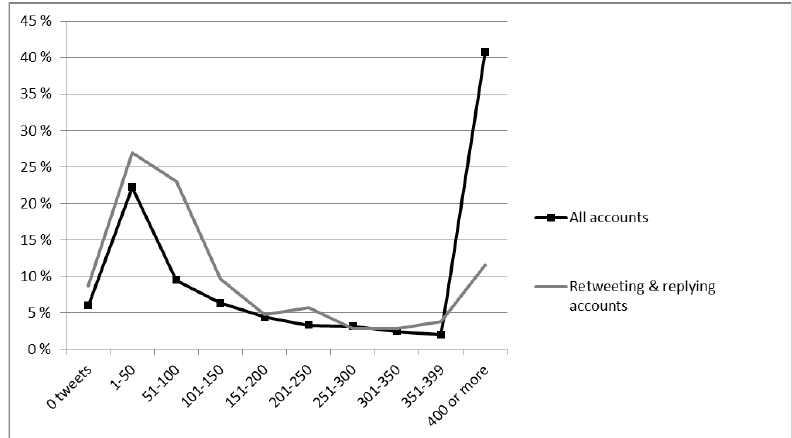
Fig. 4. The share of users in the different activity classes (tweets during the last 90 days) for all follower accounts and for those who retweeted case account tweets or replied to